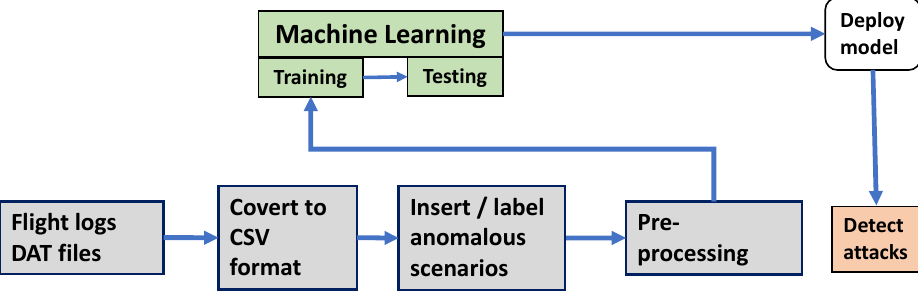
Figure 9. Framework to detect malicious attacks in UAVs.